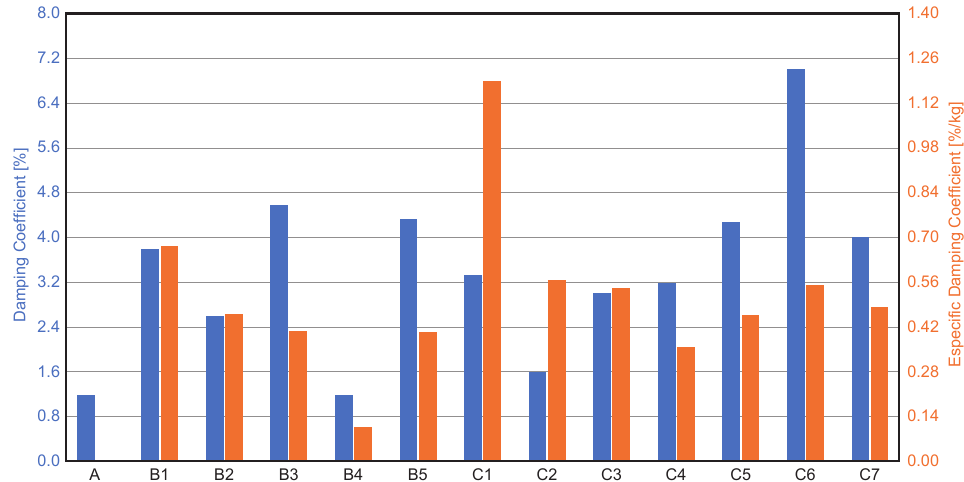
Figure 6. Damping coefficients of the first mode of vibration for the different